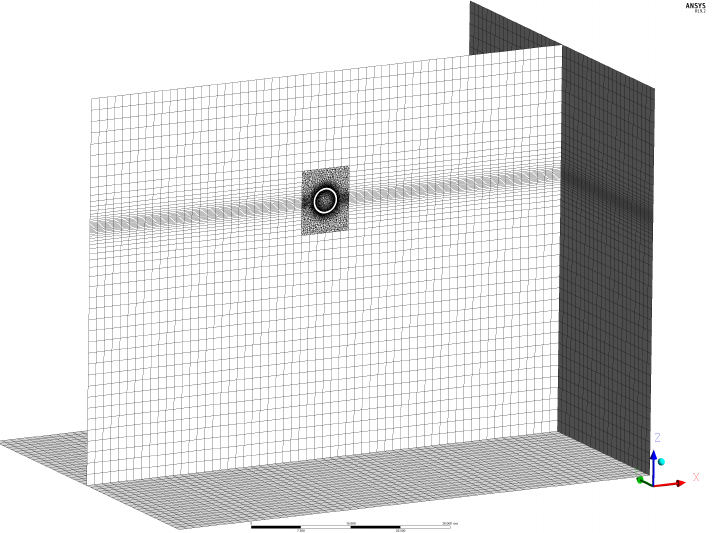
Figure 3. Mesh generation of the overall computational domain. Faces selected for presentation are bottom, outlet, and a cross-sectional face located at y = 30 m.